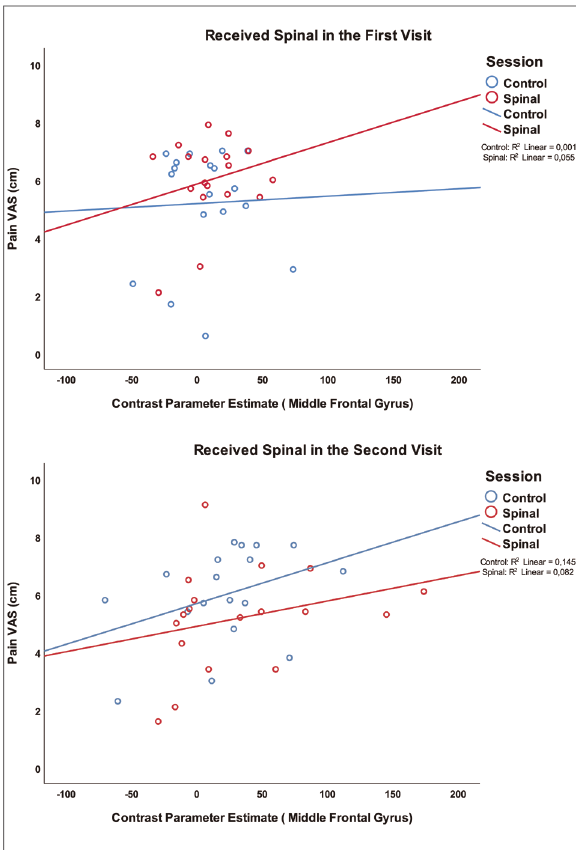
FIGURE 8 Association between pain scores and the medial prefrontal region which was signi fi cantly more activated in the group who received the spinal anesthesia in the second